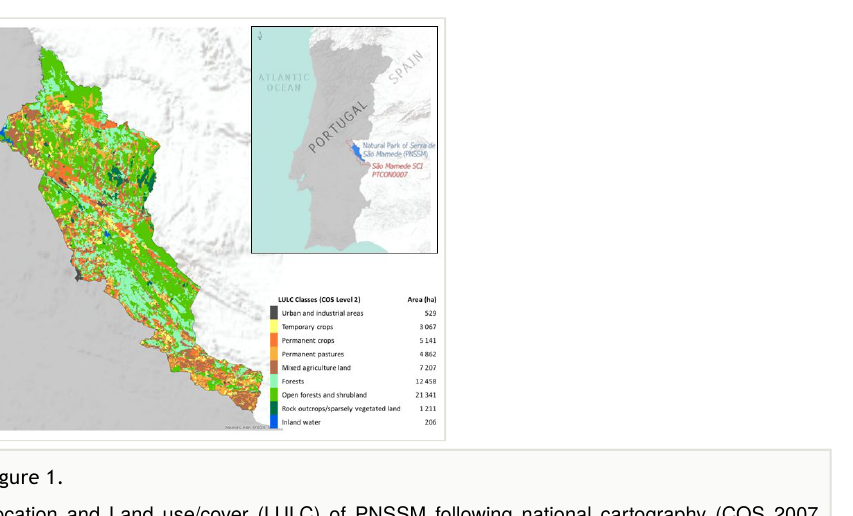
Location and Land use/cover (LULC) of PNSSM following national cartography (COS 2007 level